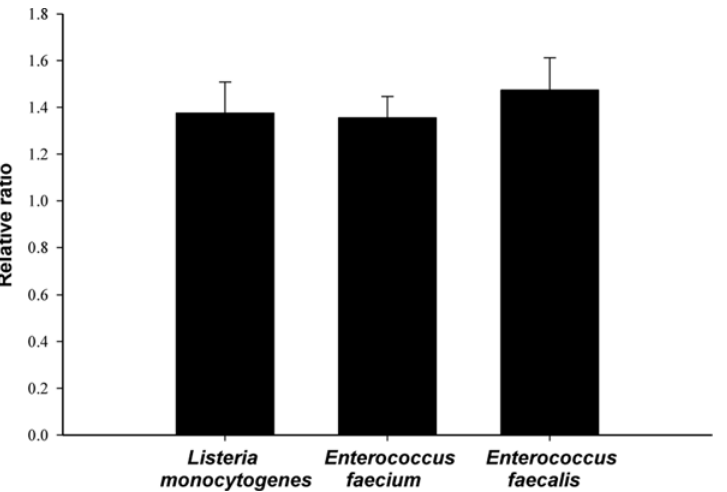
Fig 3. Leakage of material absorbing at 280 nm. After Listeria monocytogenes , Enterococcus faecium , and Enterococcus faecalis were exposed to oleanolic acid at 2 × MIC, leakage of material absorbing at 280nm was measured using spectrophotometer. The result was expressed as a relative ratio of OD 280 of oleanolic acid-treated cells to the one of oleanolic acid-untreated cells.